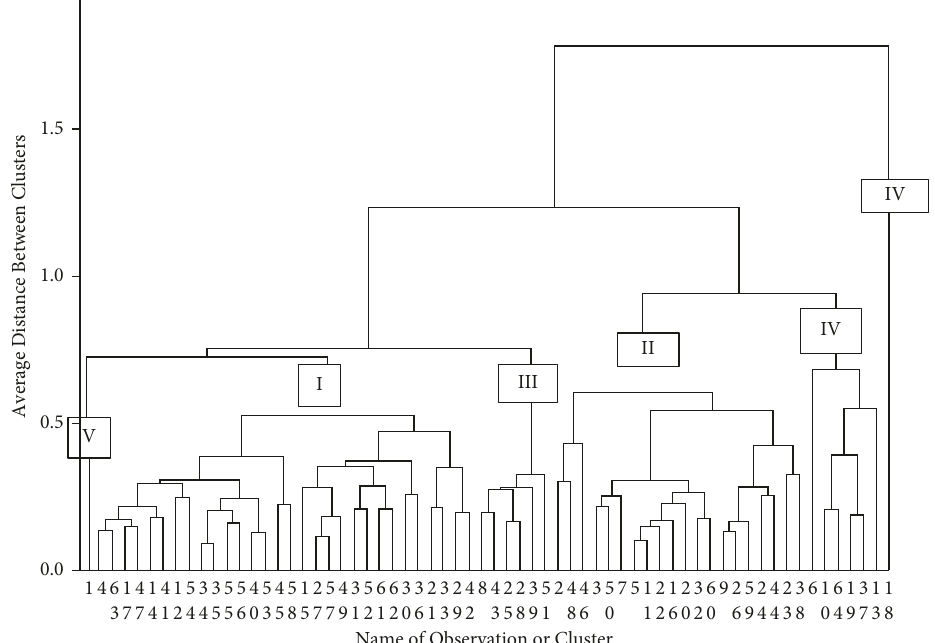
Figure 1: Dendrogram showing hierarchical clustering patterns of 64 cassava accessions (UPGMA) based on 13 biochemical